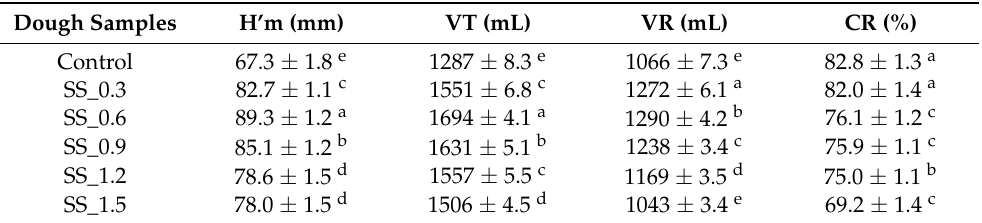
Table 4. Rheological properties during fermentation of the dough samples with different levels of sea salt with low sodium content (SS)